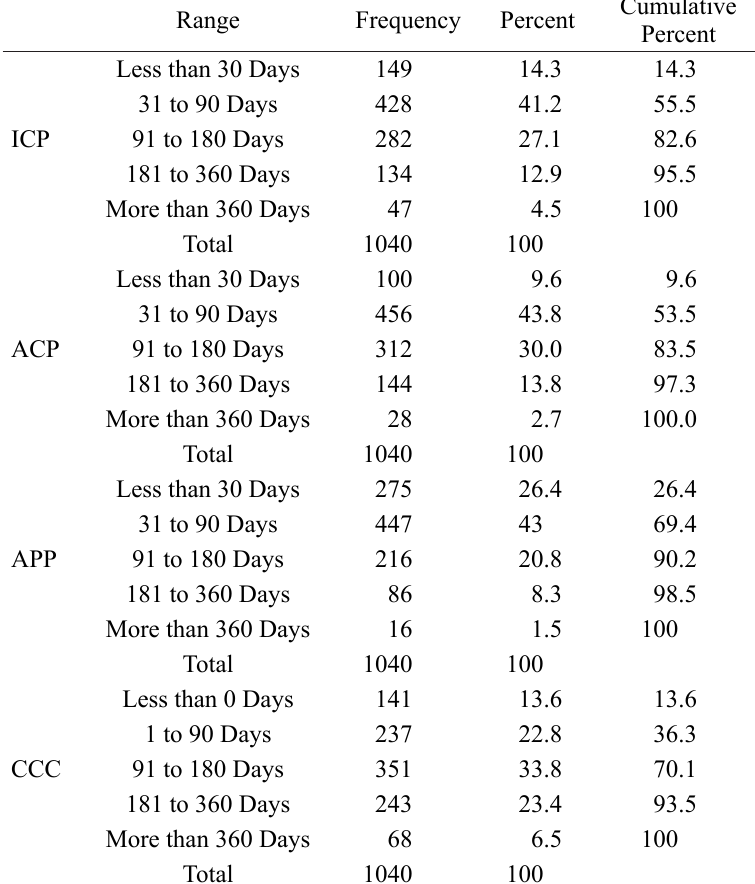
Frequency Distribution of ICP, ACP, APP and CCC